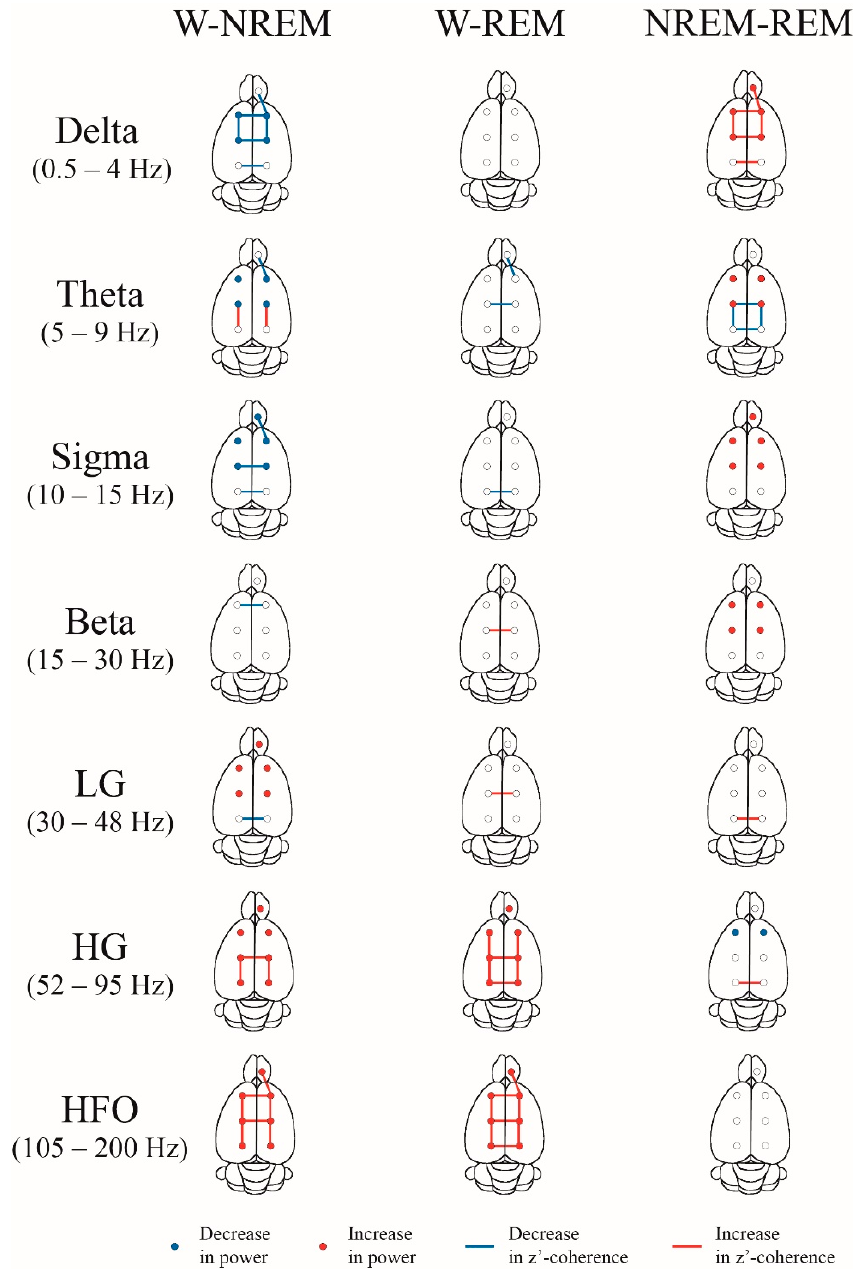
Figure 3. Summary of the power and z’-coherence. Statistically significant di ff erences in absolute power and z’-coherence during wakefulness (W), NREM and REM sleep during the light phase. The circles represent the power for the di ff erent electrodes’ positions, while the lines represent the coherence for the di ff erent derivations. The results were evaluated by means of repeated measures mixed-e ff ects model and Sidak test for multiple comparisons ( n = 11). Blue represents a significantly ( p < 0.05) lower di ff erence between two behavioral states, and red a significantly higher di ff erence. Power data are from the right hemisphere but are represented as bilateral. The complete statistics of these data are shown in Supplementary Figures S1 and